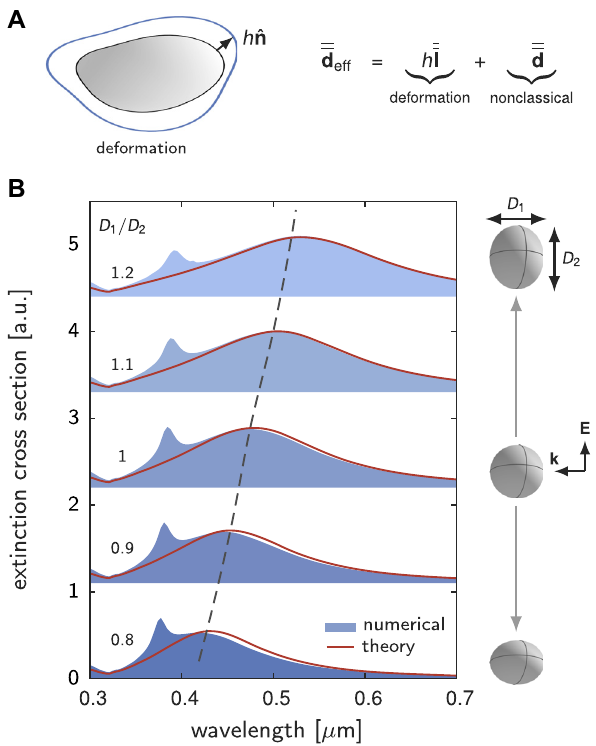
Figure 4: Modal analysis of geometrically deformed nanoparticles. (A) Optical response of a deformed nanoparticle can be effectively represented by introducing a generalized d -parameter, d . (B) eff Extinction cross-section spectra of Ag spheroids embedded in a dielectric medium with a refractive index of 1.33. In the modal method, a single dipolar mode (polarized in the direction of the incident electric field) of the sphere is used to predict the extinction = 100 nm and D ∕ D varied from 0.8 to spectra of spheroids with D 1 2 1 1.2. The retardation series in Eq. (6a) is truncated to the power k =